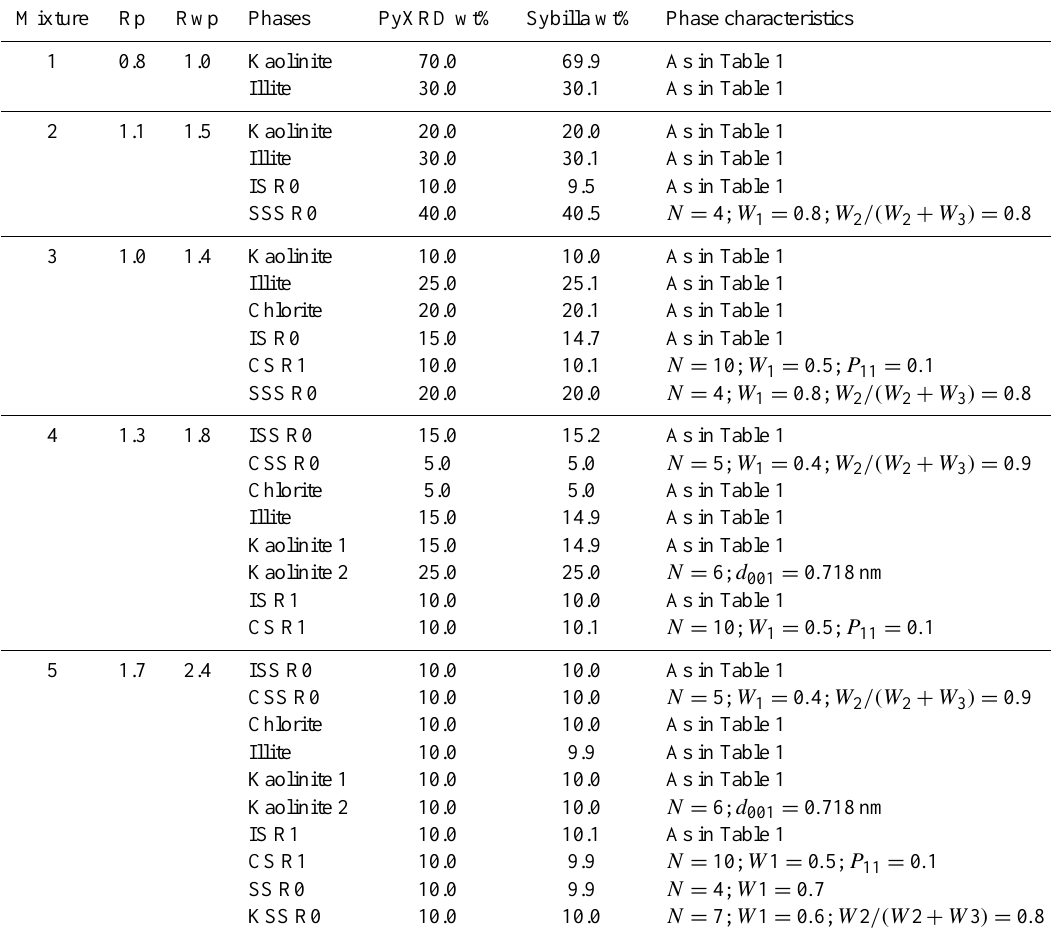
Table 2. Overview of the test mixtures used to compare the weight fraction output from PyXRD with the output of Sybilla, with details for the different phases ( R is Reichweite, N is the average CSDS, d 001 is the basal spacing, relevant probability ( P ), and weight ( W ) factors are given).